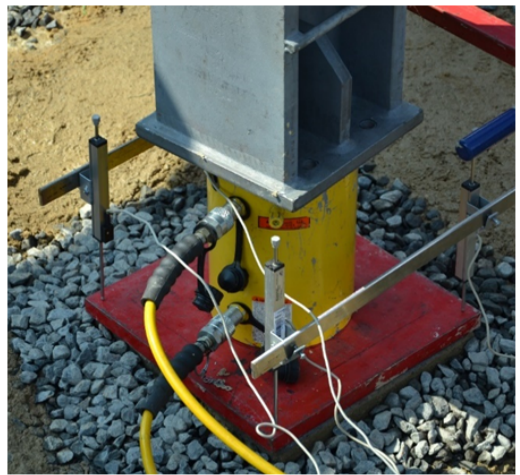
Figure 5. Installation of hydraulic press on the mi- cropile at the micropile compression load